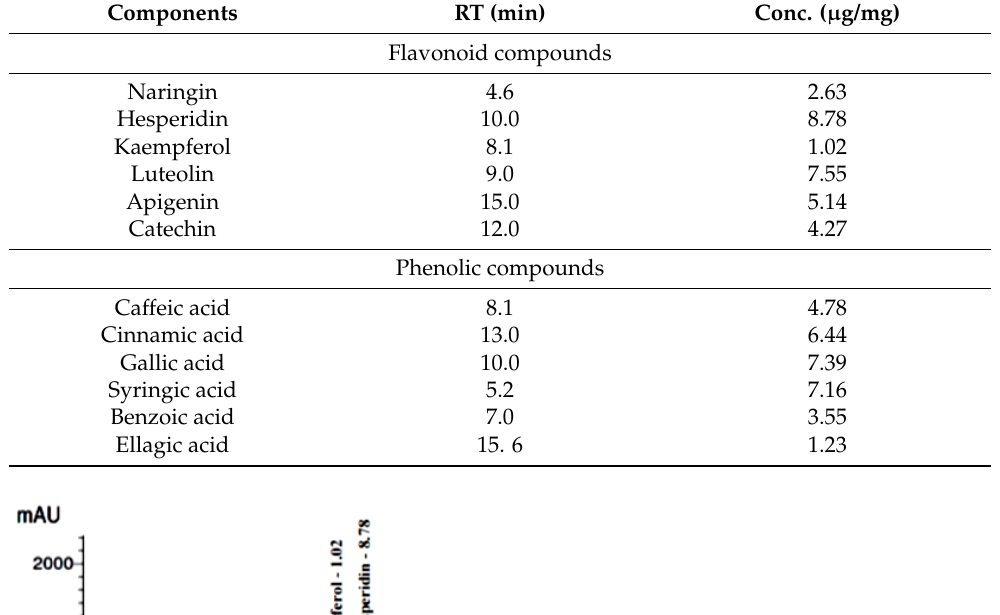
Table 4. HPLC analysis of phenolics and flavonoids in the ERF of M. arboreus . Components